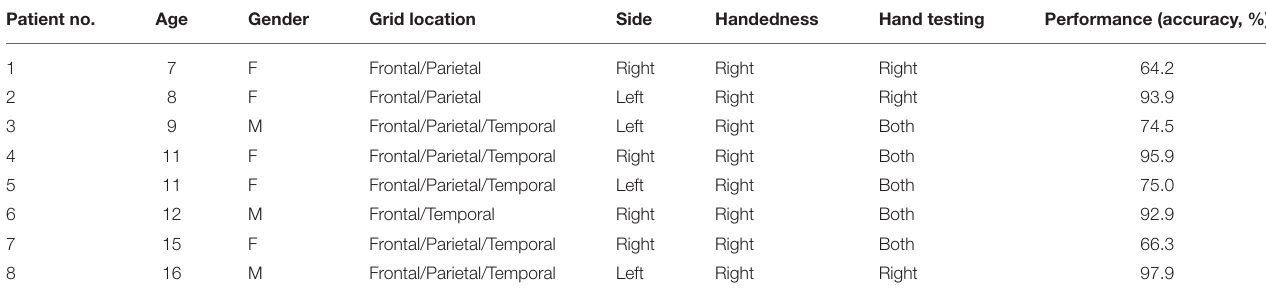
TABLE 1 | Demographical and clinical characteristics of pediatric patients implanted ECoG grids. Patient